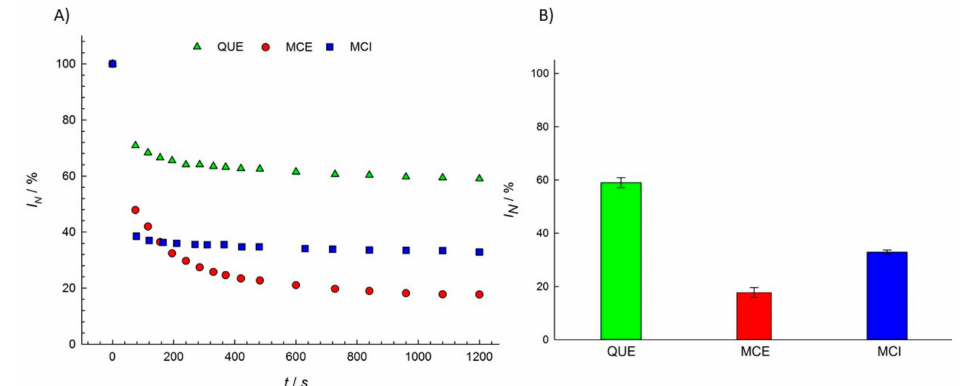
Figure 3. ( A ) The normalized EPR signal intensity of the DPPH radical measured as a function of the reaction time t; ( B ) the normalized EPR signal intensity ( I N ) of the DPPH radical at a t = 1200 s reaction time for various flavonol solutions (1 vol %). The statistical analysis showed that all the groups (QUE, MCE, MCI) significantly di ff er from each